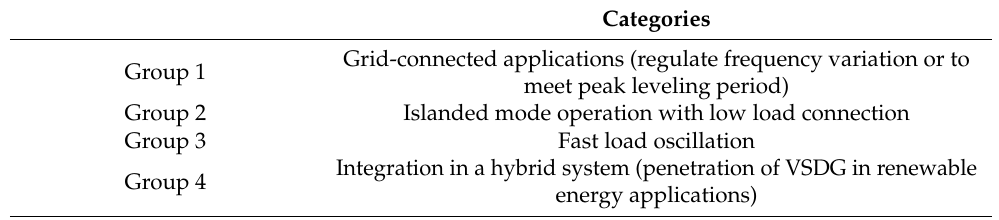
Table 1. Electric power applications.